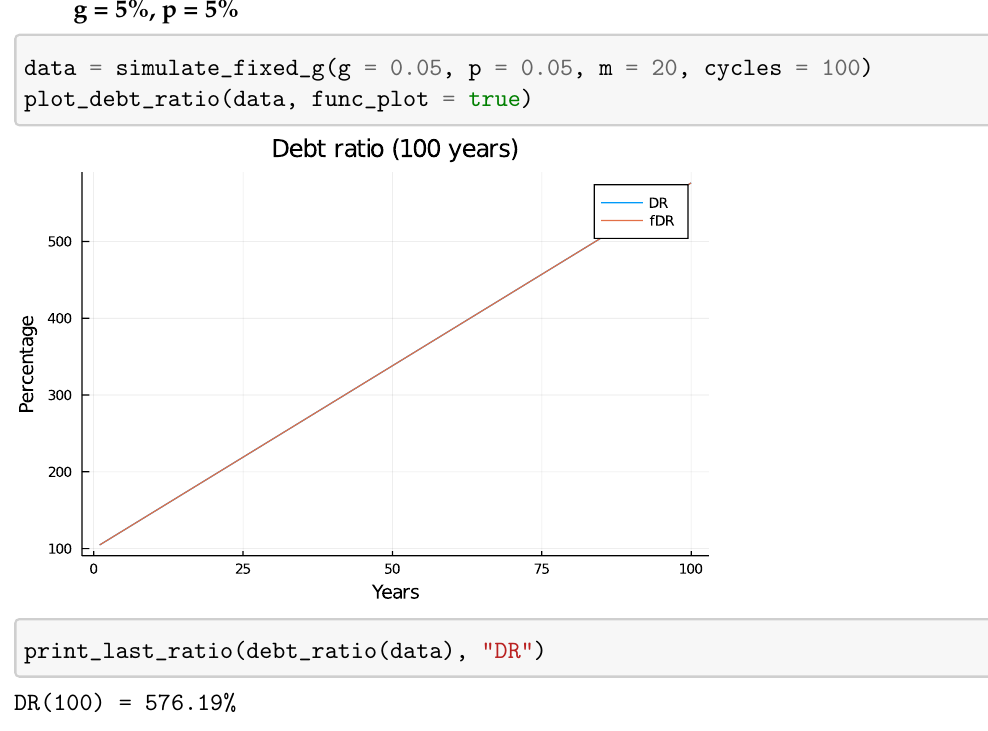
Figure 6. Debt ratio (g = 5%, p = 5%).